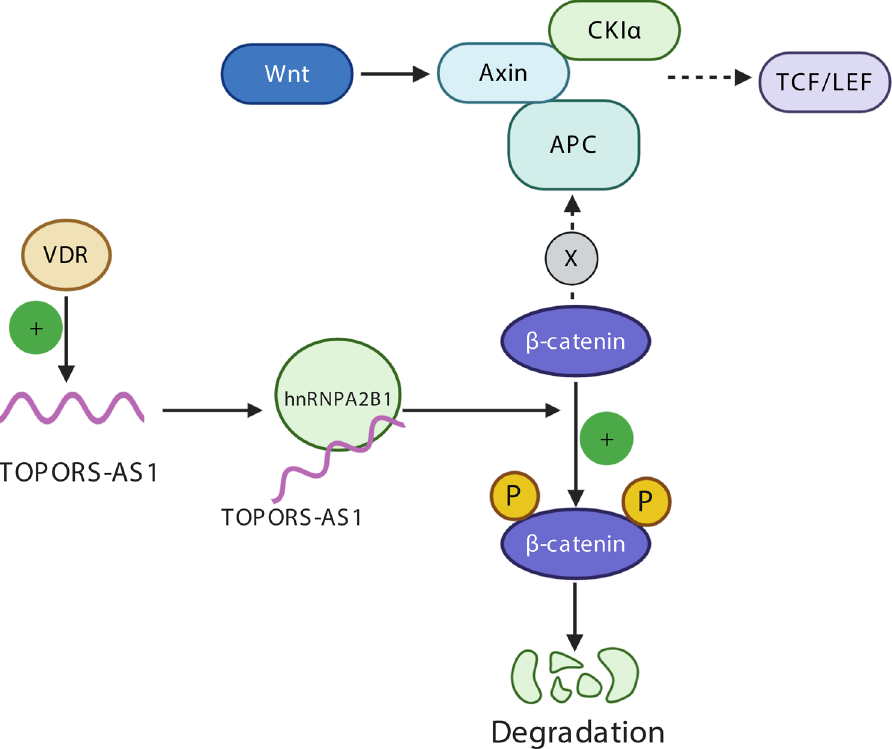
Figure 6. Schematic illustration of TOPORS-AS1 regulated by VDR, interacting with hnRNPA2B1, and inhibiting the Wnt/β-catenin